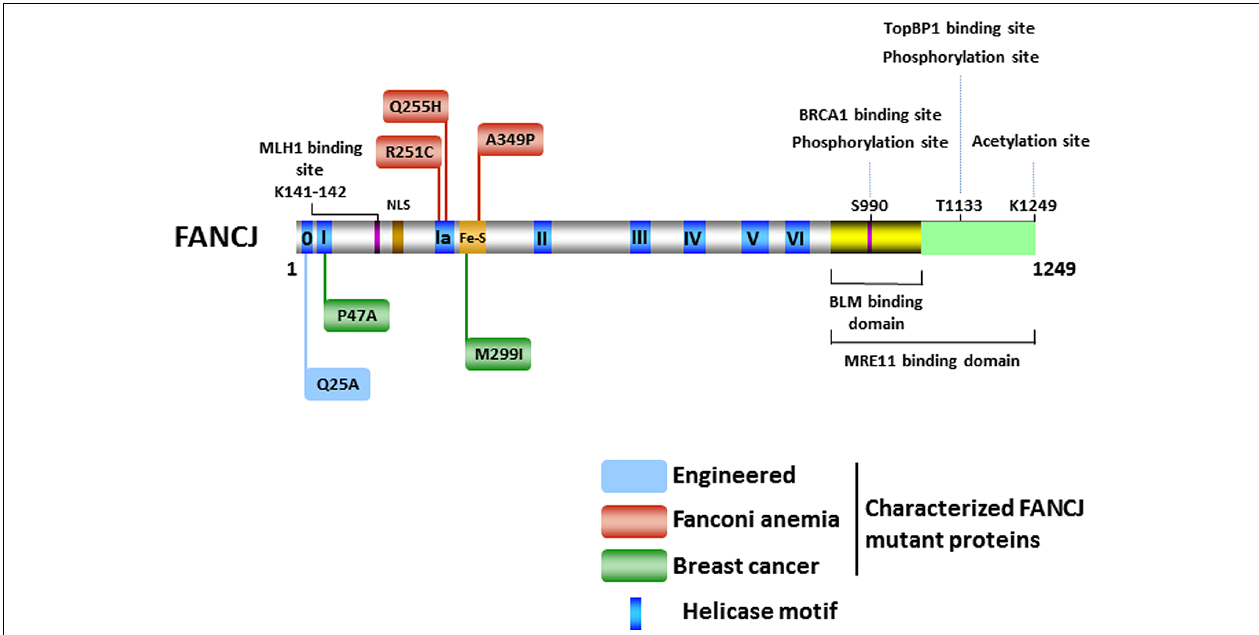
FIGURE 2 | FANCJ and its catalytic helicase domain, characterized site-directed mutations, sites of post-translational modifications, and protein interactions. See text for